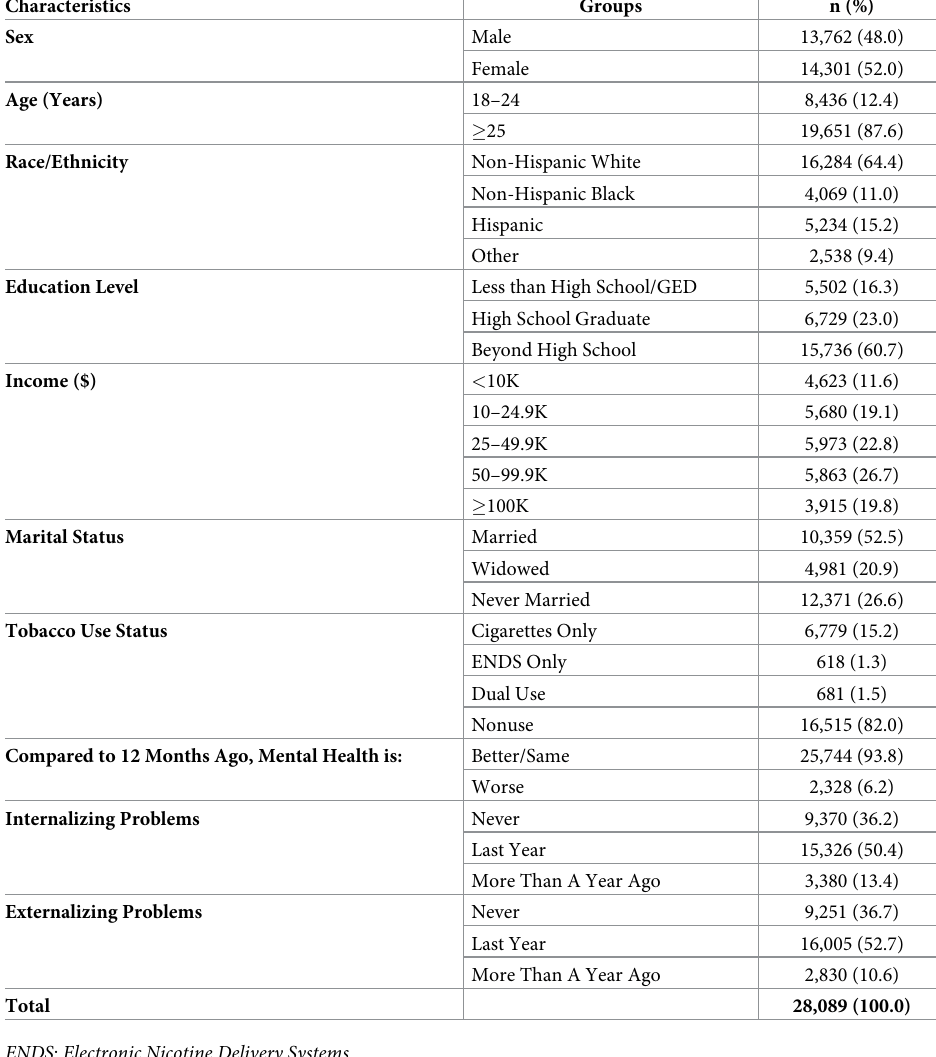
Table 2. Sociodemographic characteristics of